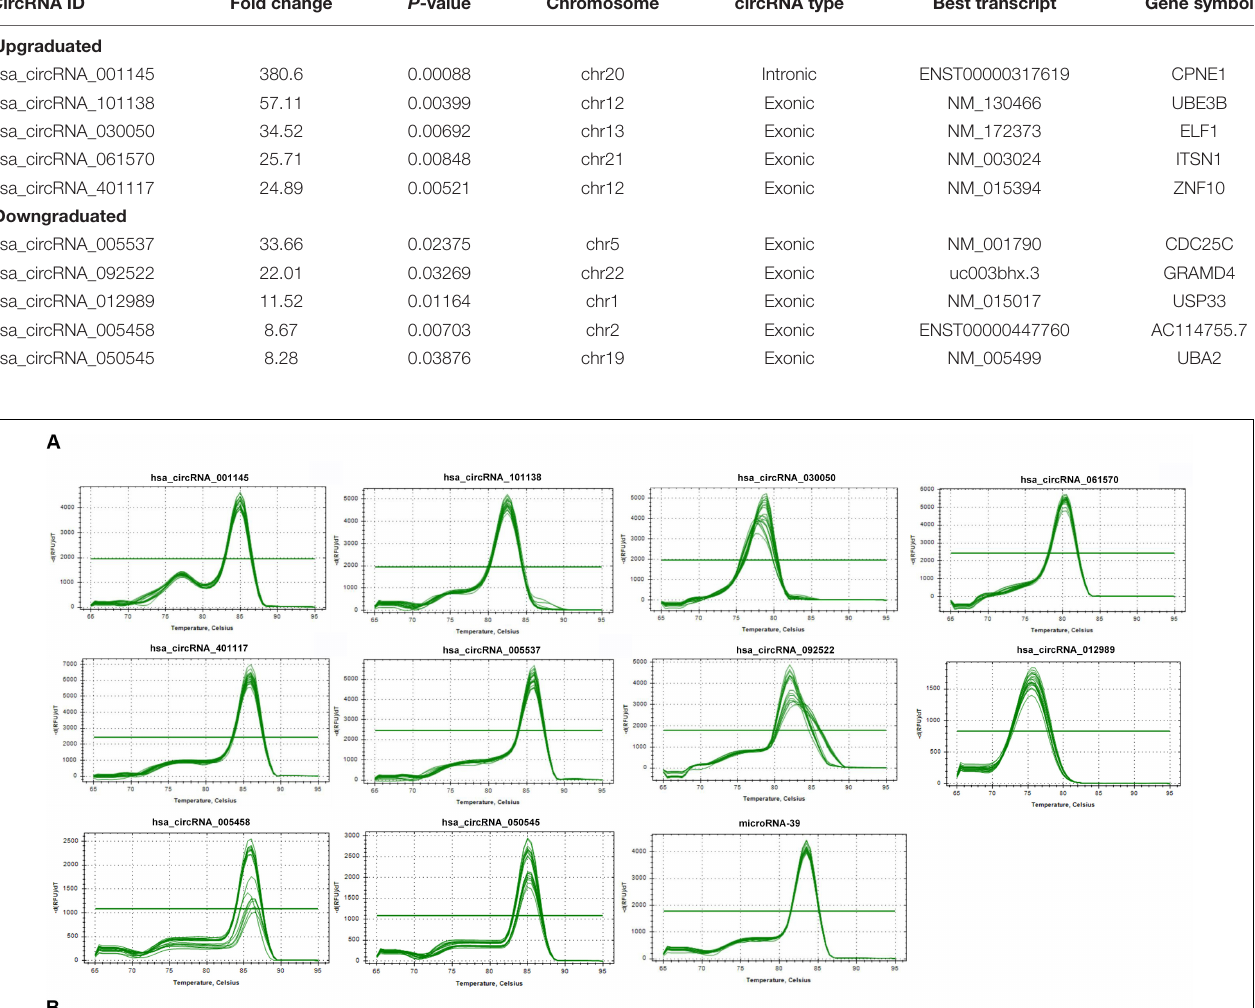
TABLE 3 | Biological information for the top five upregulated and downregulated circRNAs. CircRNA ID Fold change